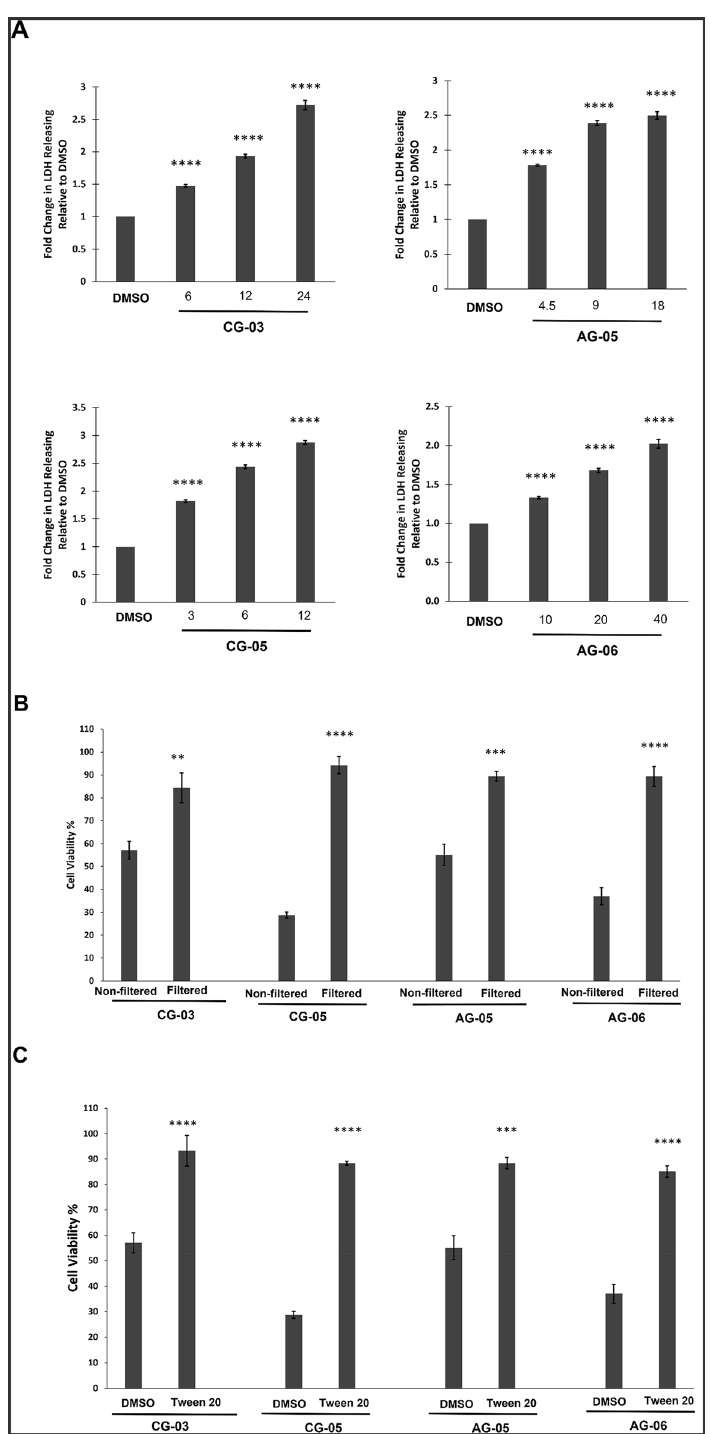
Figure 5. The cytotoxic activity of analogs depends on particle formation like AG-08. ( A ) LDH release was determined following the treatment of HCC1937 cells with 1-, 2- and 4-fold of IC 50 values of cytotoxic compounds or vehicle (DMSO) for 16 h. The level of released LDH was calculated as fold change relative to vehicle. ( B ) Compounds (2-fold of IC 50 values; 12 µM CG-03, 6 µM CG-05, 9 µM AG-05 and 20 µM AG-06) or vehicle solutions prepared in cell condition medium was filtered by 0.22 µm filter and replaced with normal medium. After 24 h, cell viability was measured. ( C ) The cell medium was replaced with fresh medium containing Tween 20 (1:40,000) and compounds (2-fold of IC 50 values; 12 µM CG-03, 6 µM CG-05, 9 µM AG-05, and 20 µM AG-06) or vehicle. Cell viability after 24 h was measured. The reported values correspond to mean values ± standard deviation (± s.d) of three experiments. ***p < 0.001, ****p <